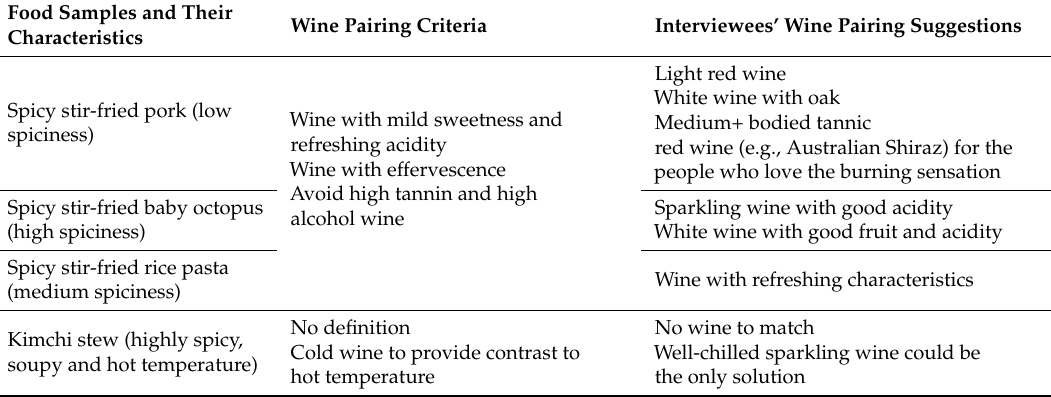
Table 3. Comparison between the pairing criteria and the interviewees’ wine suggestions for spicy food